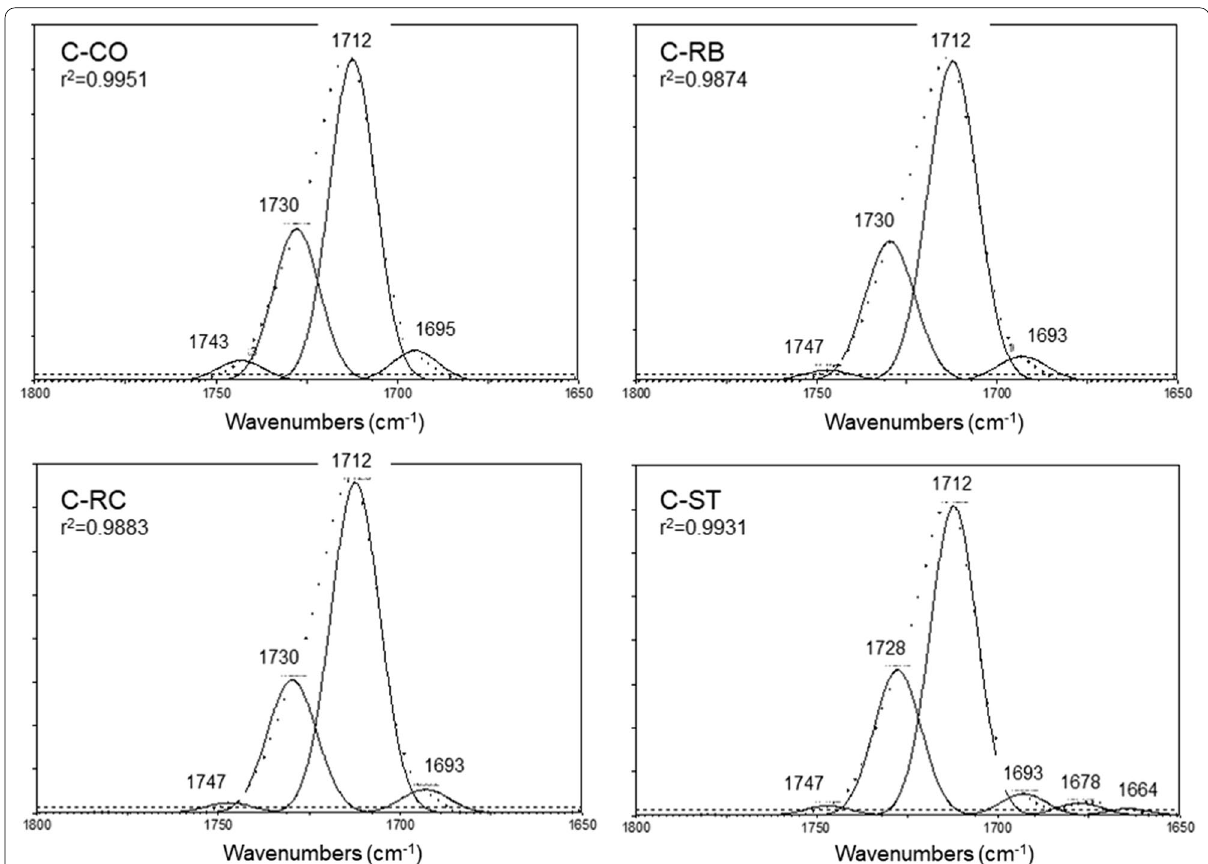
Fig. 3 Gaussian curve-fitting of the ester peak of Clear Aligner before (CO) and after treatments with Retainer Brite (RB), Retainer Cleaner (RC) and Steraligner (ST) cleaners. The additional peak after ST cleaner at 1669 cm − 1 of Fig. 2 is analyzed in two peaks at 1678 cm − 1 and 1664 indicating formation of acid derivatives (1800–1650 cm − 1 range, absorbance scale, dotted lines: original spectra, r 2 : coefficient of determination for the goodness of